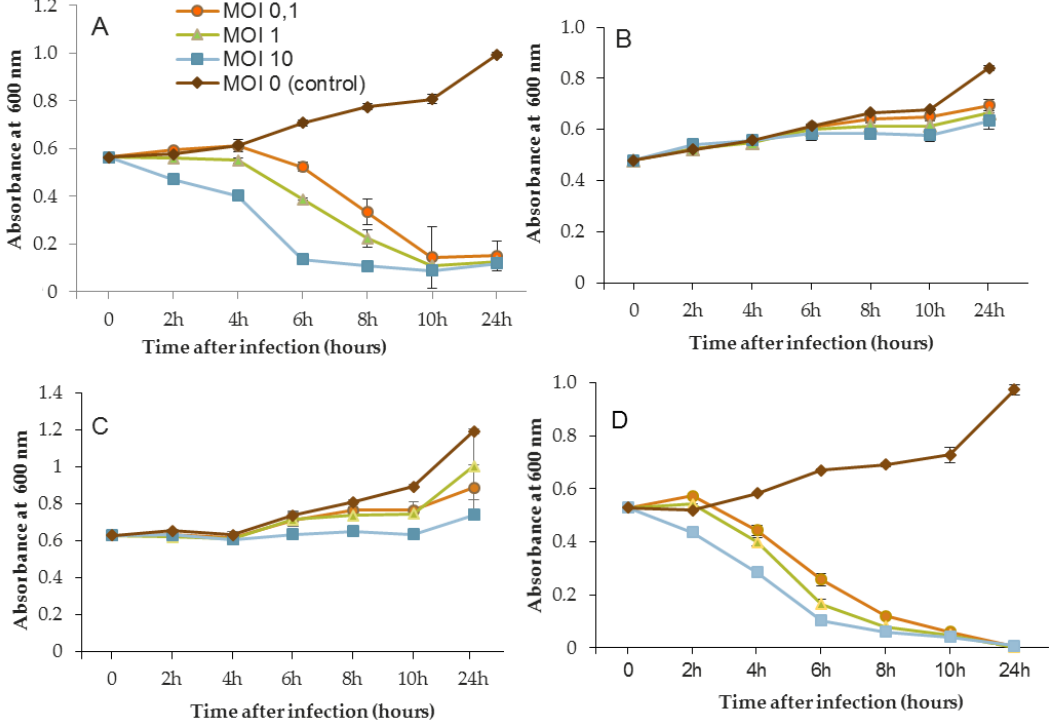
Figure 4 . Activity of the phage 14.1 against planktonic cells of four different P. aeruginosa strains (A) D1, ( B ) MLM, ( C ) ST395E, ( D ) PAO1. Each experiment was performed in triplicate, and bars indicate D1, (B) MLM, (C) ST395E, (D) PAO1. Each experiment was performed in triplicate, and bars indicate standard deviations. Multiplicity of infection standard deviations. Multiplicity of infection (MOI).